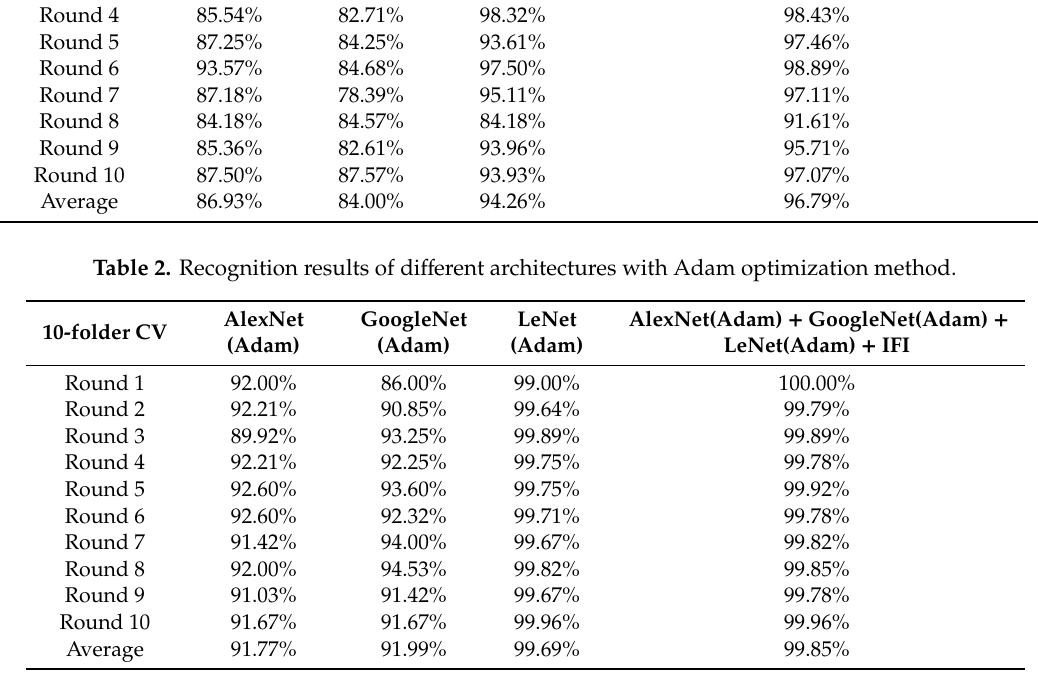
Table 3. Recognition results of di ff erent architectures with stochastic gradient descent (SGD) optimization